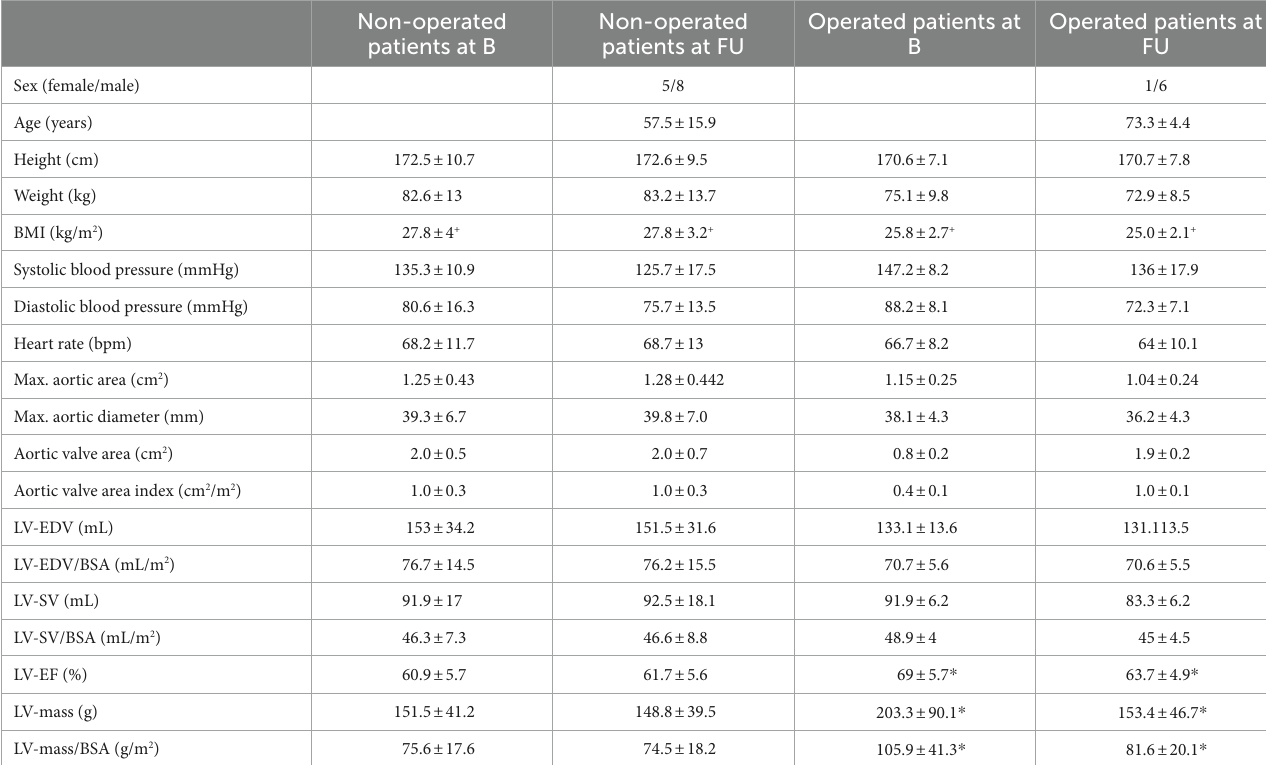
TABLE 1 Patients’ characteristics at baseline (B) and follow up